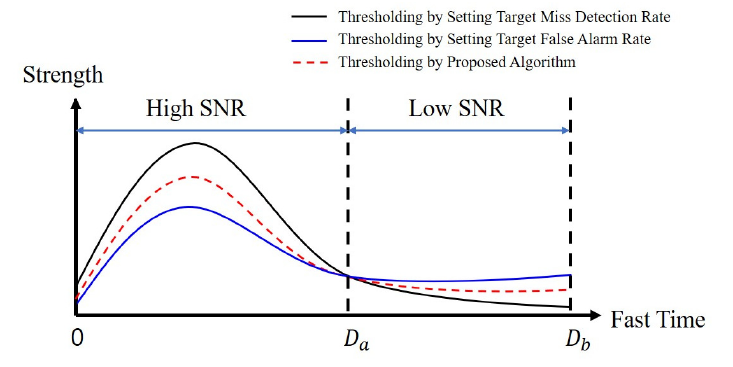
Figure 6. Example of the proposed thresholding